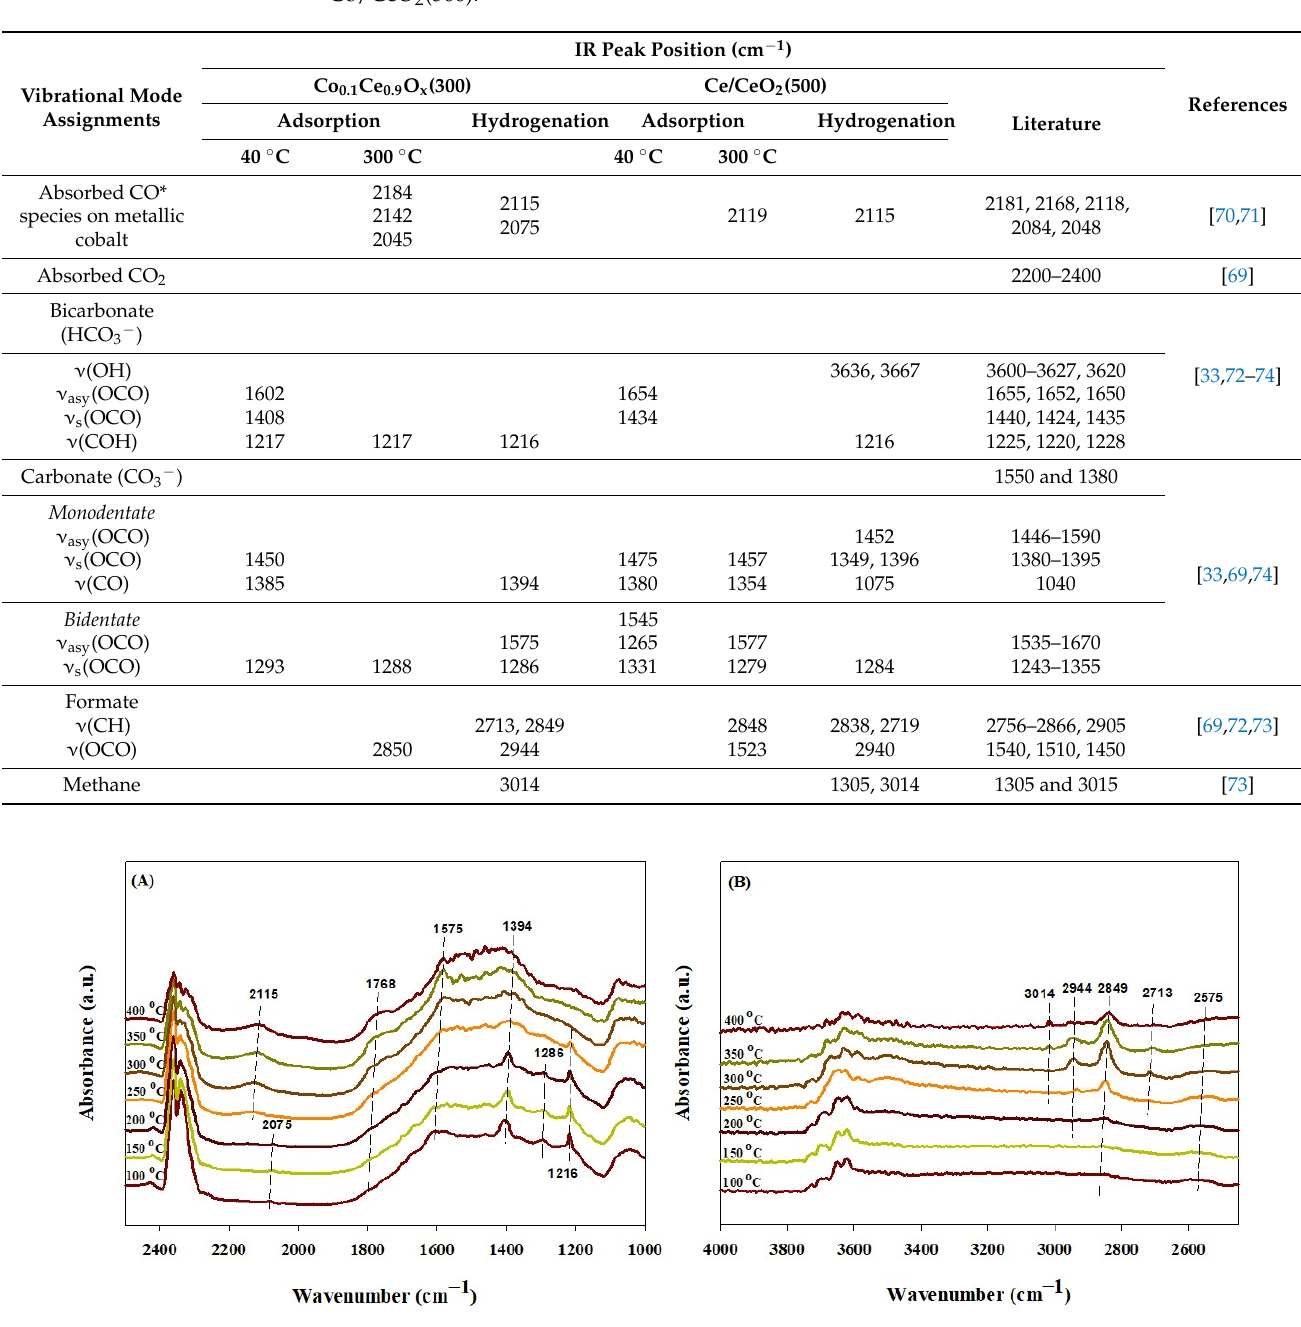
Figure 6. In situ DRIFTS spectra during CO 2 methanation at temperatures of 100-450 ◦ C over the Co 0.1 Ce 0.9 O x (300) catalyst in the range of 2500–1000 cm − 1 ( A ) and 2500-4000 cm − 1 ( B ). The feed is composed of 1 mol% CO 2 , 49 mol% He, and 50 mol% H 2